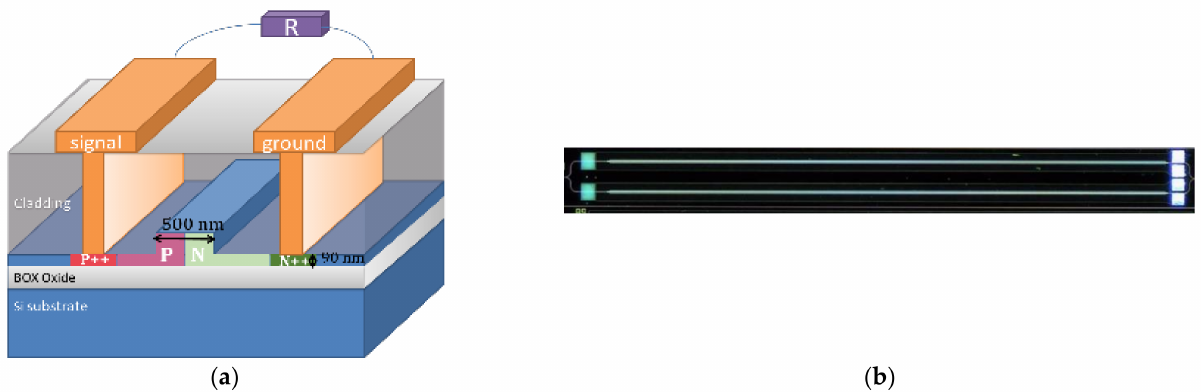
Figure 1. ( a ) Schematic of essential device structure and ( b ) optical microscopic image of a fabricated